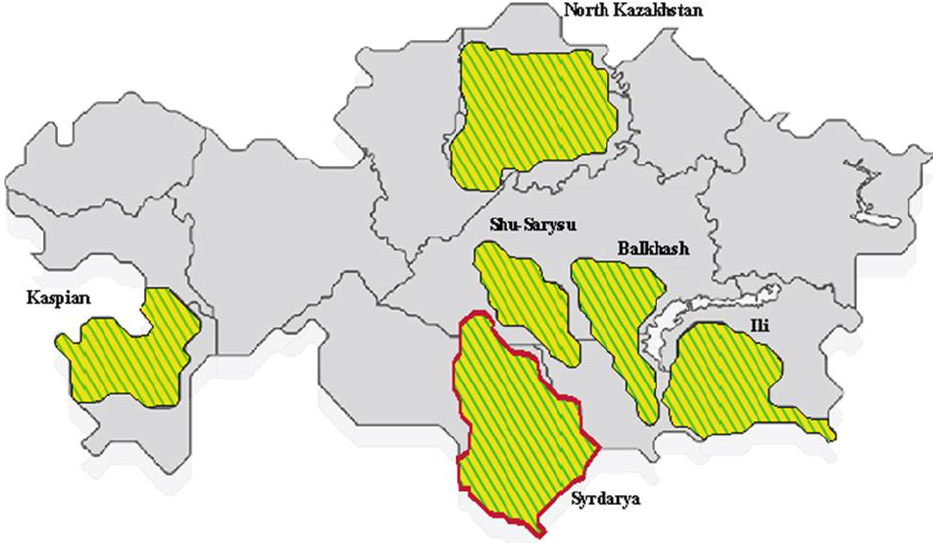
Figure 1. Uranium provinces of Kazakhstan, indicating the distribution of uranium reserves: Syrdarya (10.2%); North Kazakhstan (13.1%); Shu — Sarysu (66.8%); Ili (6.1%); Caspian (3.1%); Pribalkhashskaya (0.7%) [7].